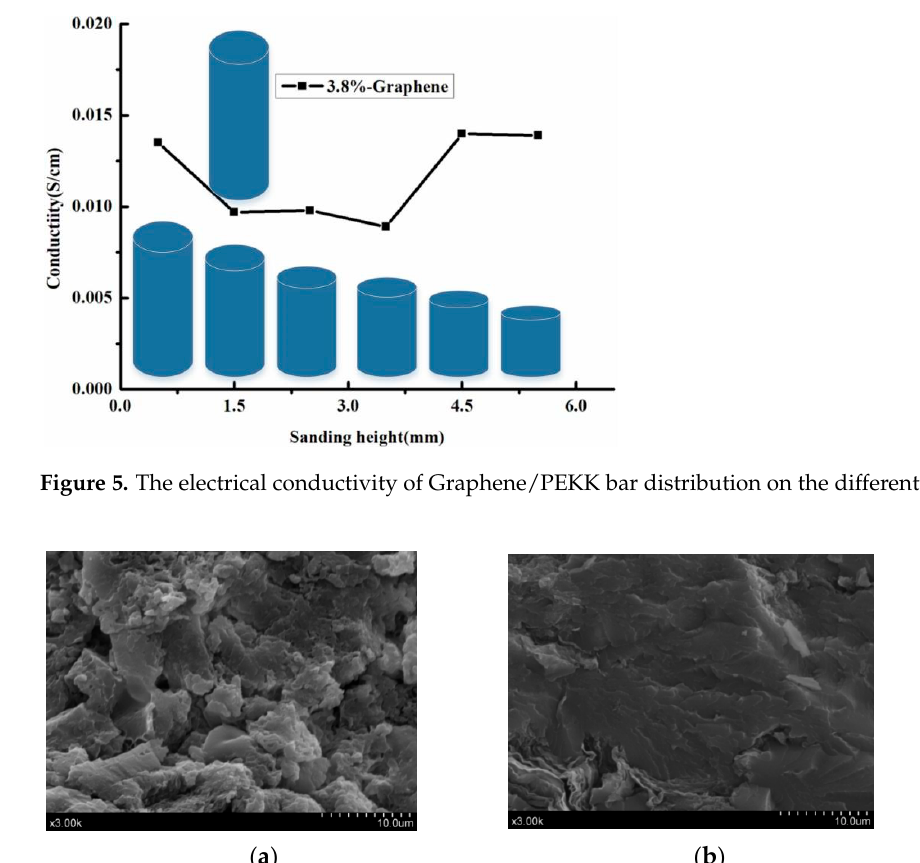
Figure 6. SEM analysis Graphene/PEKK and pure PEKK bar by spark plasma sintering. ( a ) Pure- PEKK; ( b ) Graphene/PEKK composite.